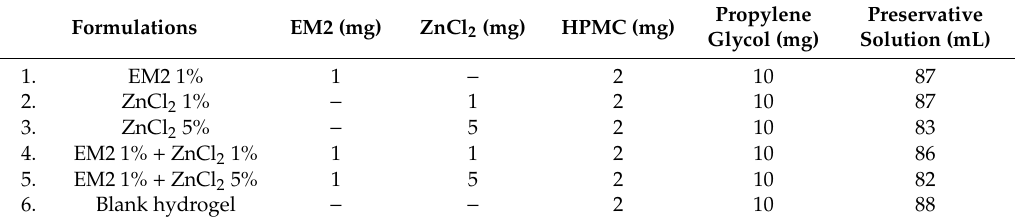
Table 3. EM2 and ZnCl 2 formulations [29]. HPMC: hydroxypropyl methylcellulose.